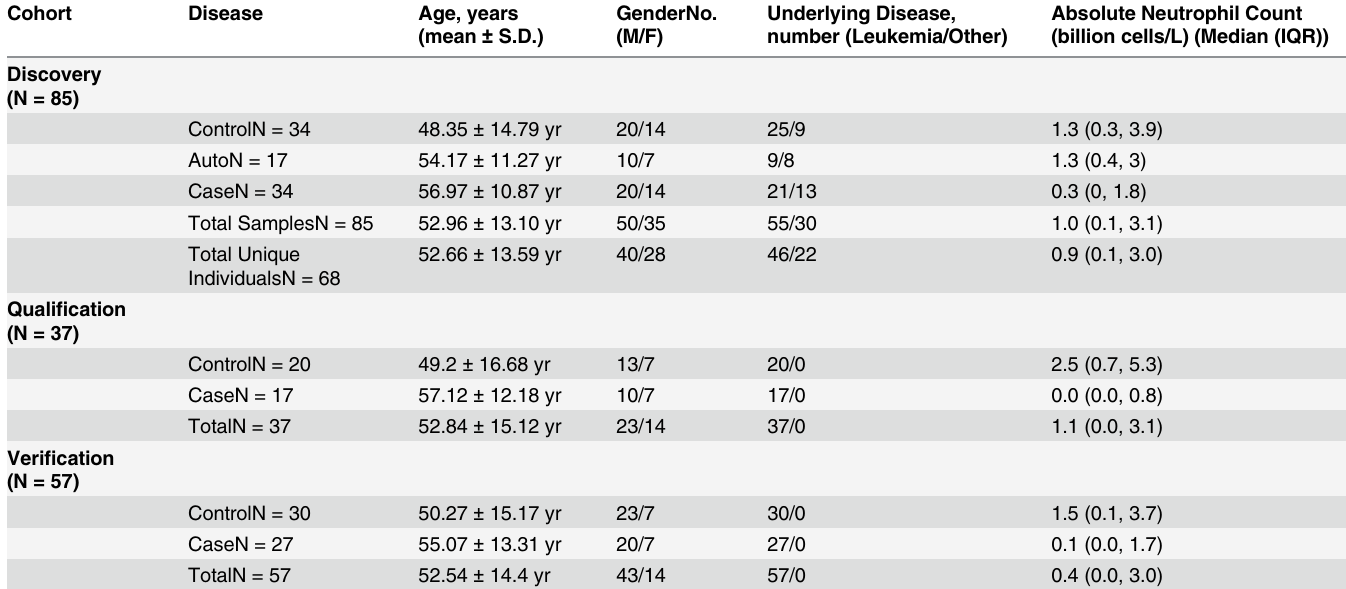
Table 1. Characteristics of study cohorts.